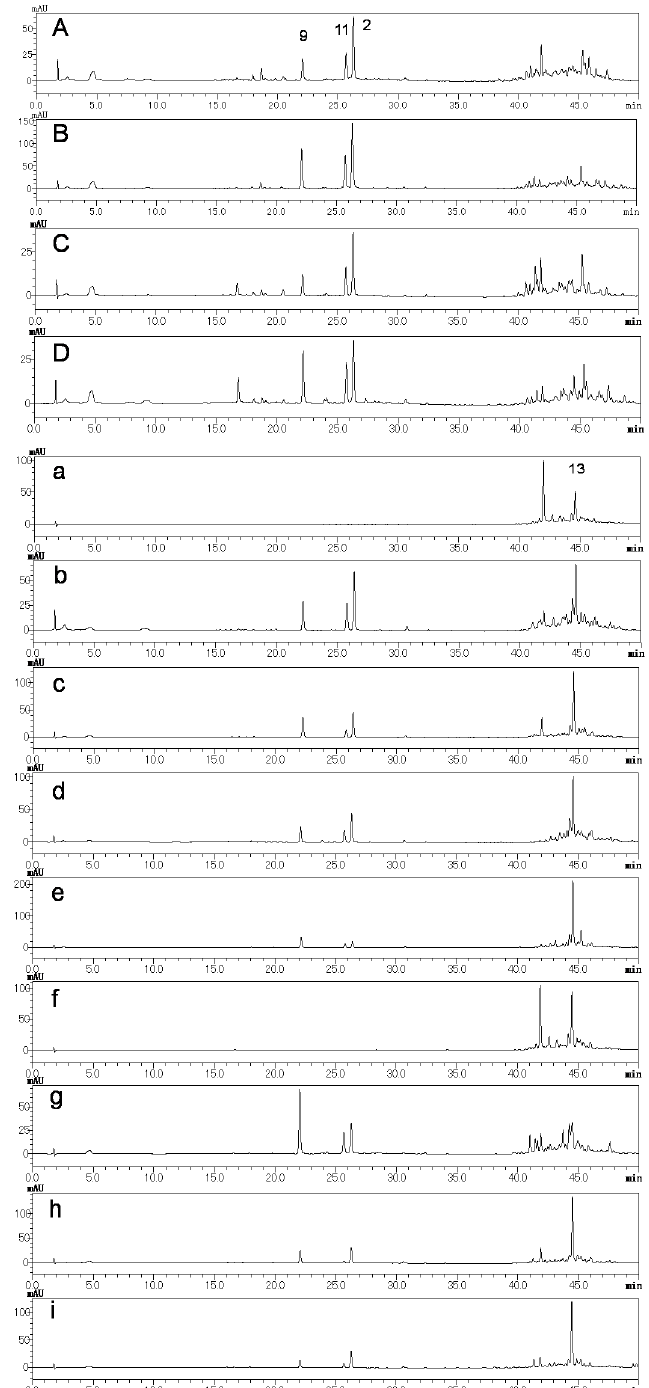
Figure 5. HPLC chromatograms of the crude drug extracts identified as Cynanchi Wilfordii Radix (CWR) ( A – D ) and Cynanchi Auriculati Radix (CAR) ( a – i ). The number on the chromatogram corresponds to the compound number. HPLC conditions are described in condition 1 of Section 3.